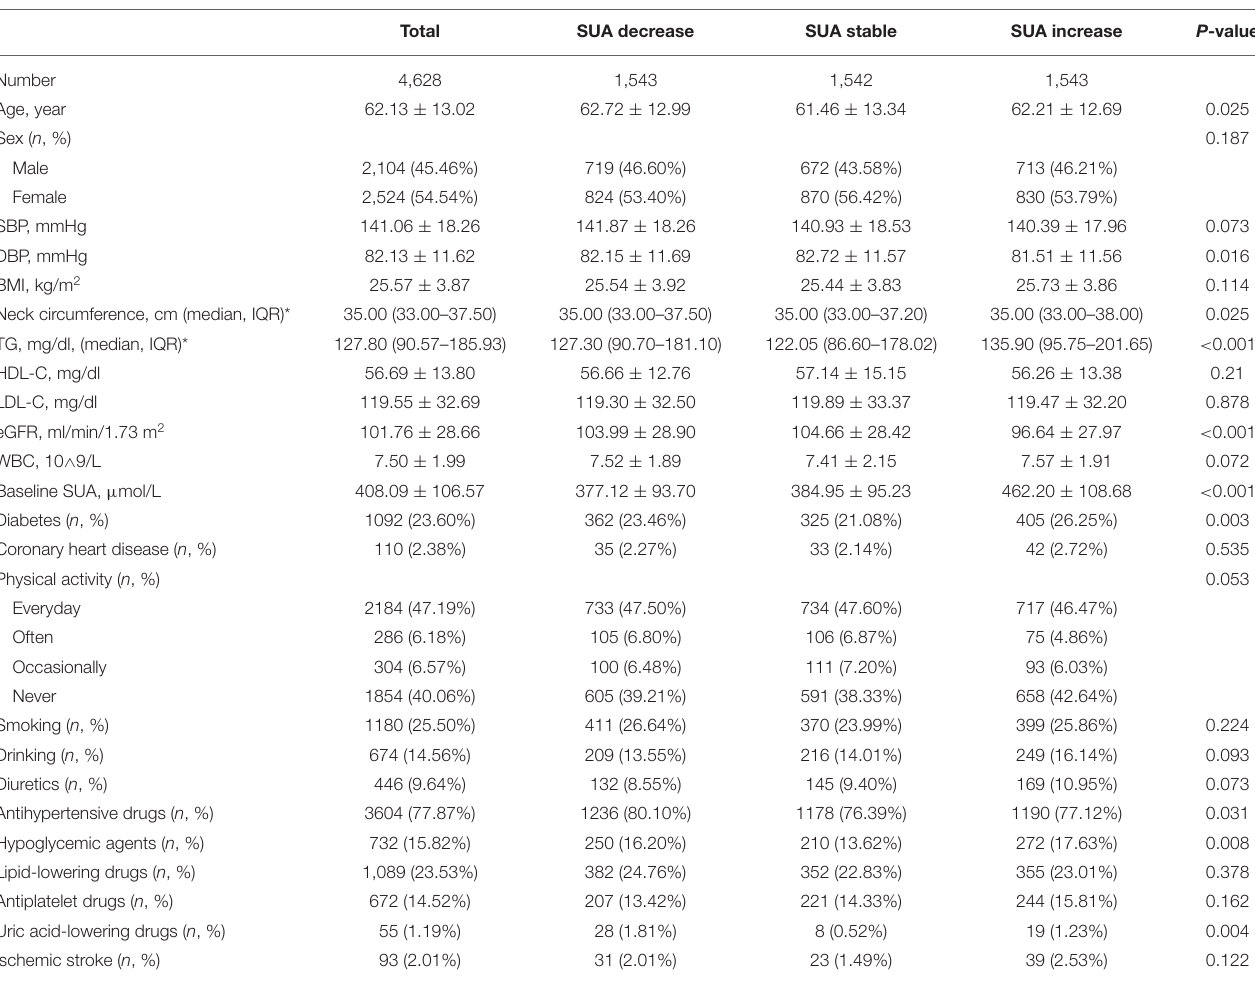
TABLE 1 | Baseline characteristics of participants.